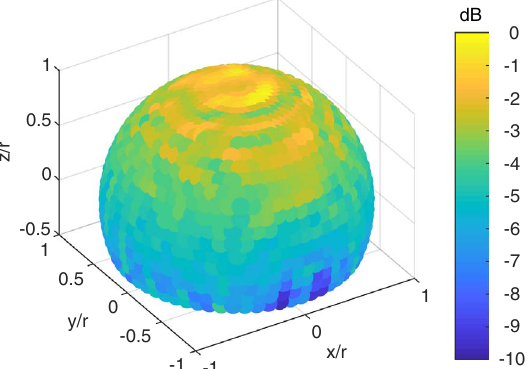
Figure 5. Ultrasonic welding machine of the “ HiQ SOLID PropControl ” series made by Herrmann Ultraschalltechnik GmbH & Co. KG. A welding machine of this series, “ HiQ SOLID SDM 20 kHz ” type, was used as the ultrasound source. Co.